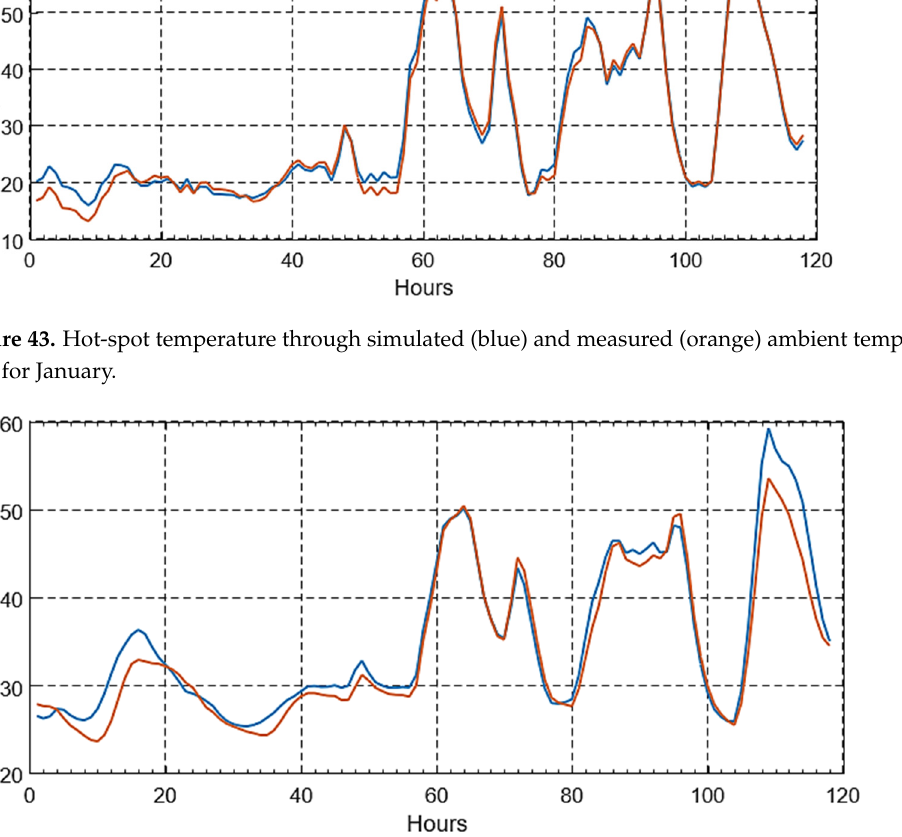
Figure 44. Oil temperature at the top of the transformer through simulated (blue) and measured (orange) ambient temperature for August.